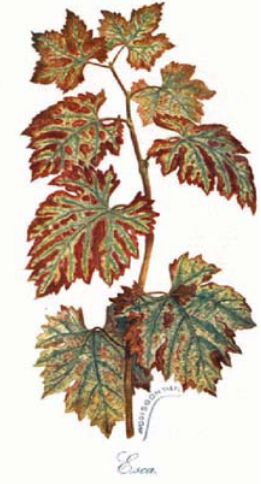
Fig. 1. Depiction of tiger striped leaves of grapevine in Viala,